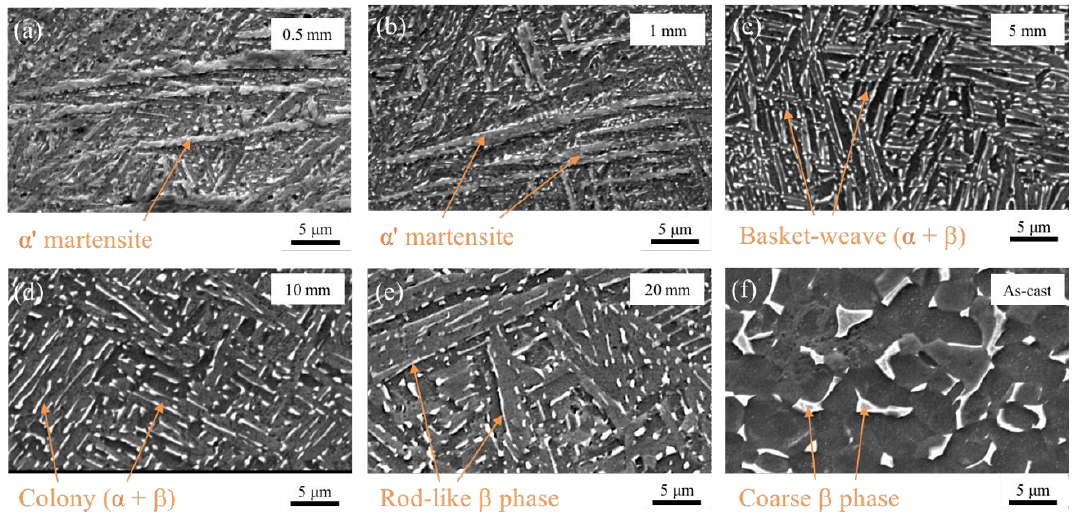
Figure 4. ( a – f ) SEM micrographs of EBM-built Ti64 samples with thicknesses of 0.5, 1, 5, 10, and 20 mm and the as-cast Ti64 samples, respectively. Microstructural features are indicated by arrows.